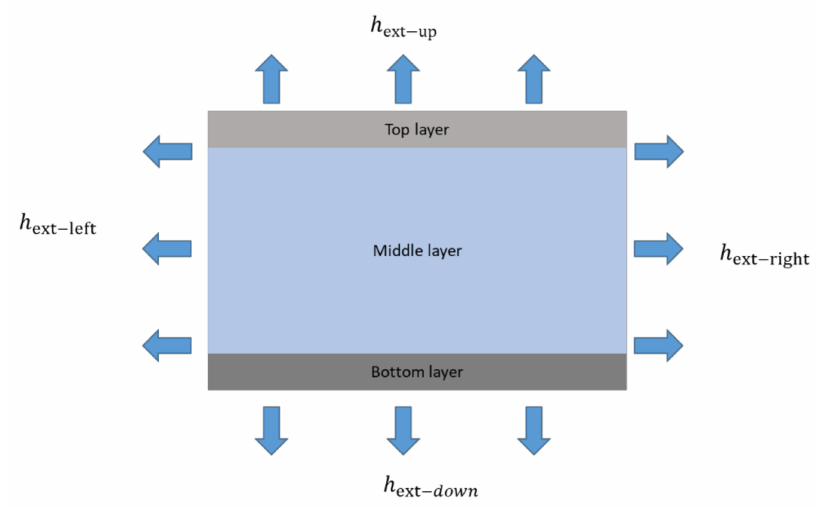
Figure 1. The boundary of a proton exchange membrane fuel cell (PEMFC).